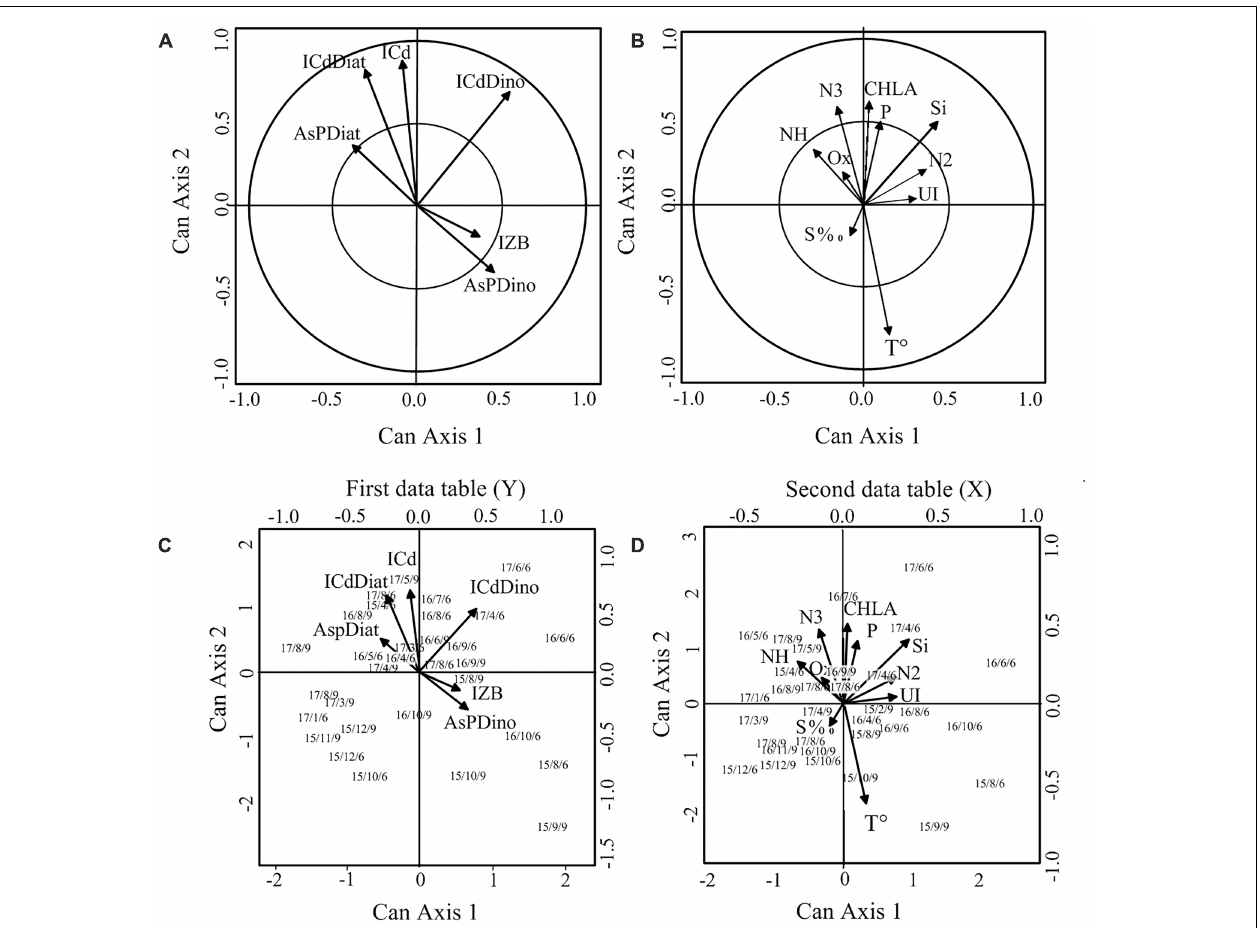
FIGURE 13 | Canonical correlation analysis procedure biplots. (A) Biological variables; (B) environmental variables; (C) position of sampling stations included in the analysis and the biological variables; (D) position of sampling stations included in the analysis and the environmental variables. ICd, log cell density total; lCdDiato, log diatoms cell density; lCdDino, log dinoflagellates cell density; AsPDiat, arcsine of the percentage of diatoms; AsPD, arcsine of the percentage of diatoms. (C,D) Characters chain mean year/month/station